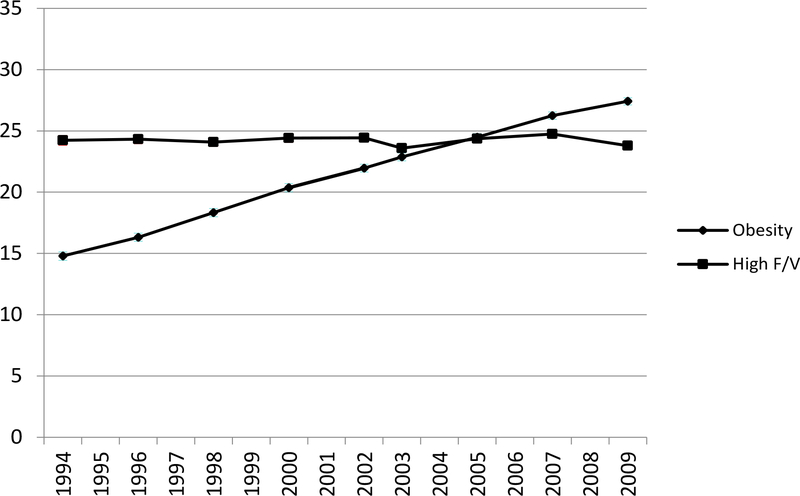
Observed overall prevalence of FV5/day and obesity prevalence in the U.S.